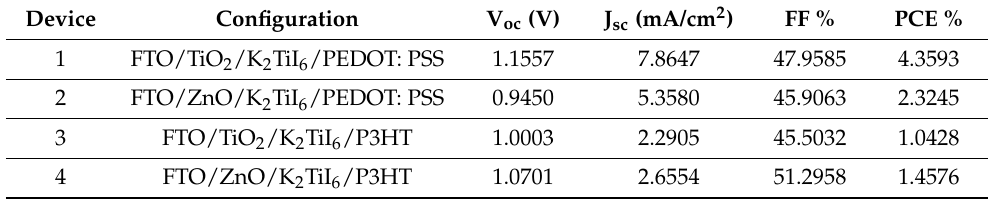
Table 3. Comparative analysis of cell parameters for K 2 TiI 6 based PSCs.